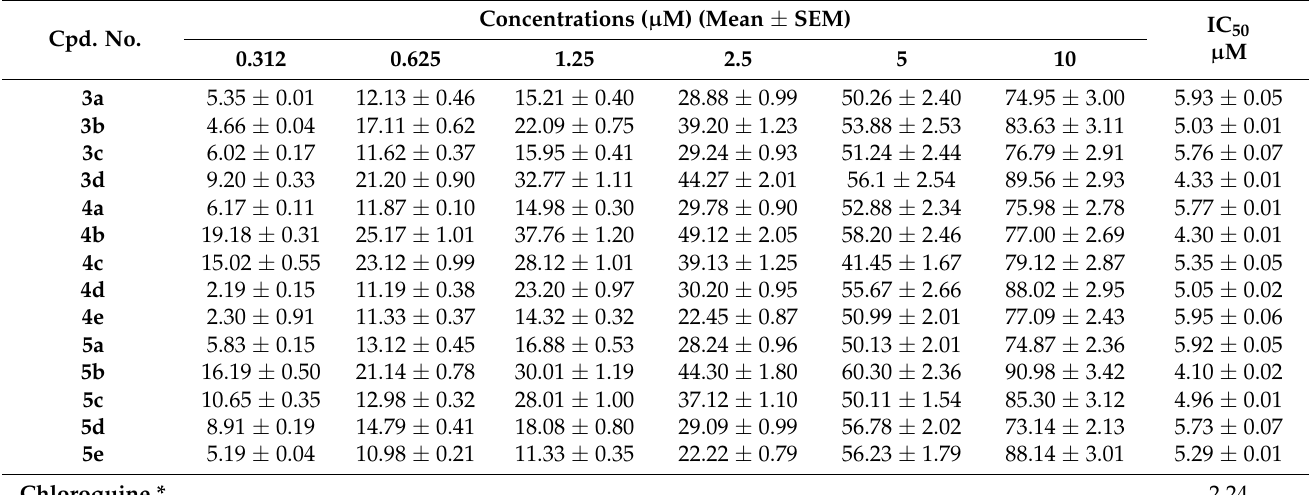
Table 1. % Viability and IC 50 of the newly synthesized compounds, and chloroquine at different concentrations.